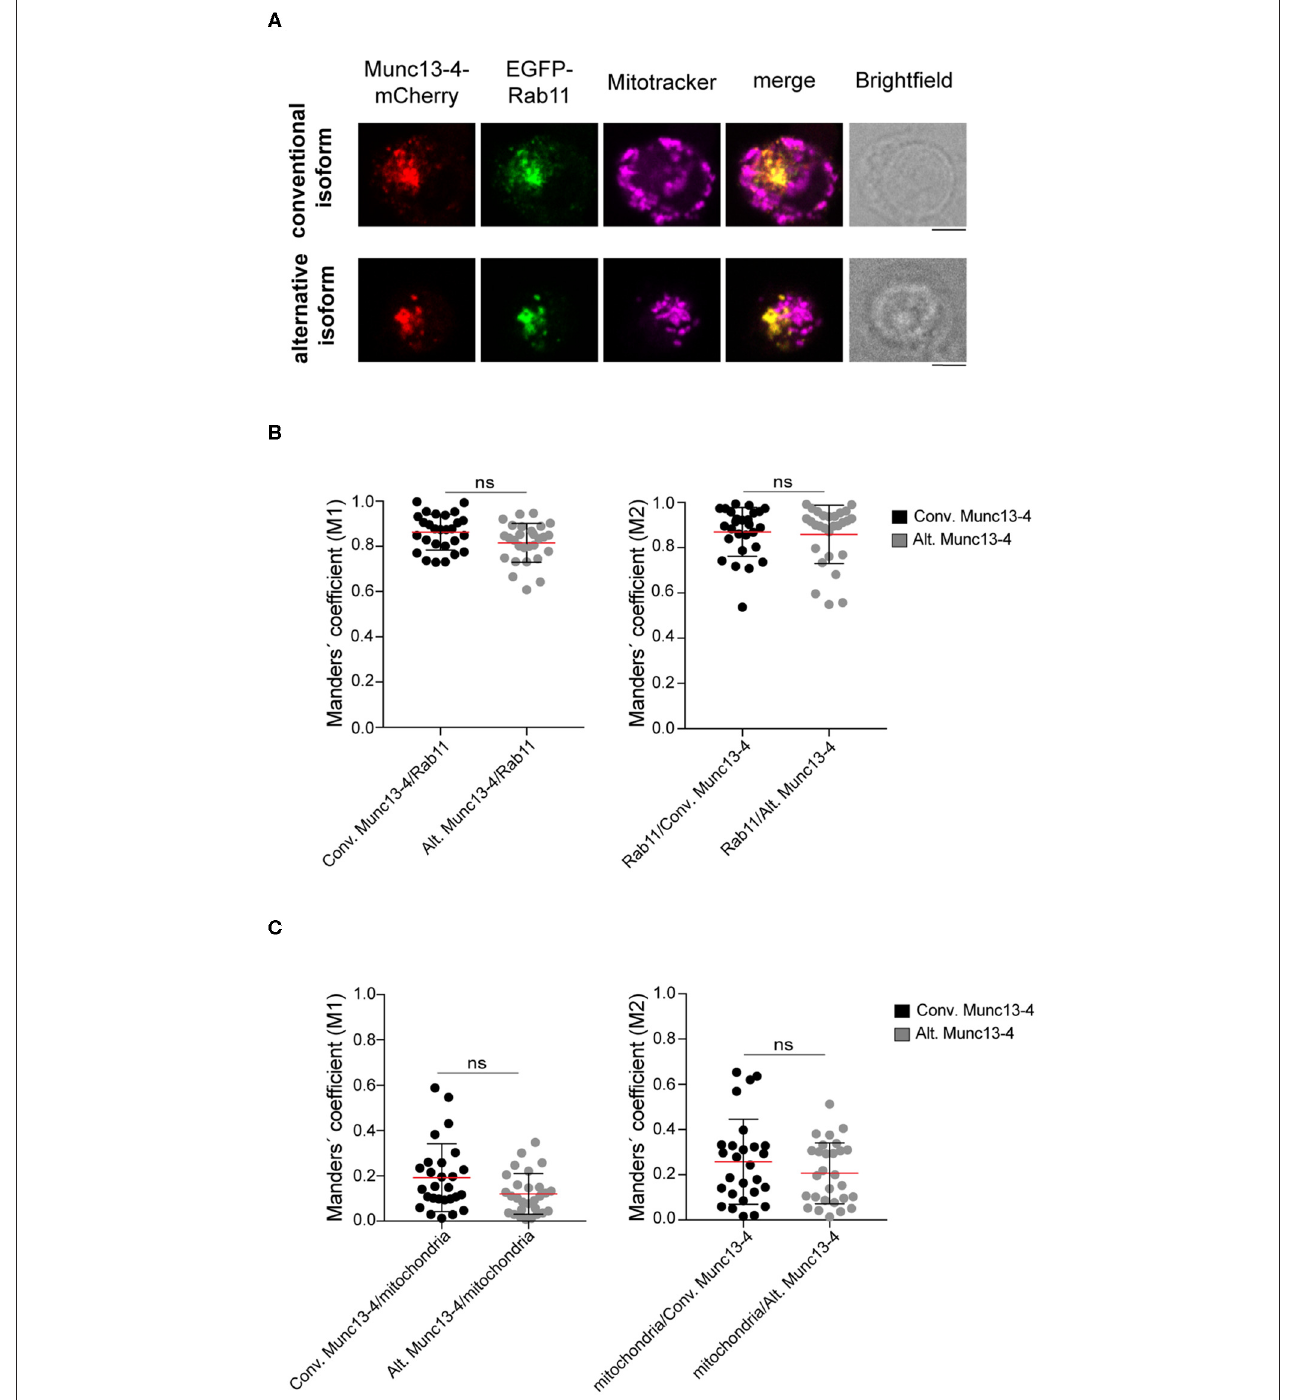
FIGURE 3 | Colocalization of Munc13-4 isoforms with intracellular vesicular compartments. (A) Cytotoxic CD8 + T cells from healthy donors were transfected with EGFP-Rab11a and conventional (top) or alternative (bottom) Munc13-4-mCherry, stained with Mitotracker to label mitochondria and imaged by confocal microscopy. Representative images are shown. (B,C) Quantification of Munc13-4 and Rab11 (B) or Munc13-4 and mitochondria (C) colocalization was calculated as Manders’ overlap coefficient. Plots represent cumulative data from two healthy donors ( n = 27 cells for conventional Munc13-4, n = 28 cells for alternative Munc13-4). Data from each donor are displayed individually in Figure S4 . Bars depict mean ± SD, whereas dots represent single cells. P -values were calculated using a two-sided Mann-Whitney test. ns, non-significant. Scale bar indicates 5 µ M.